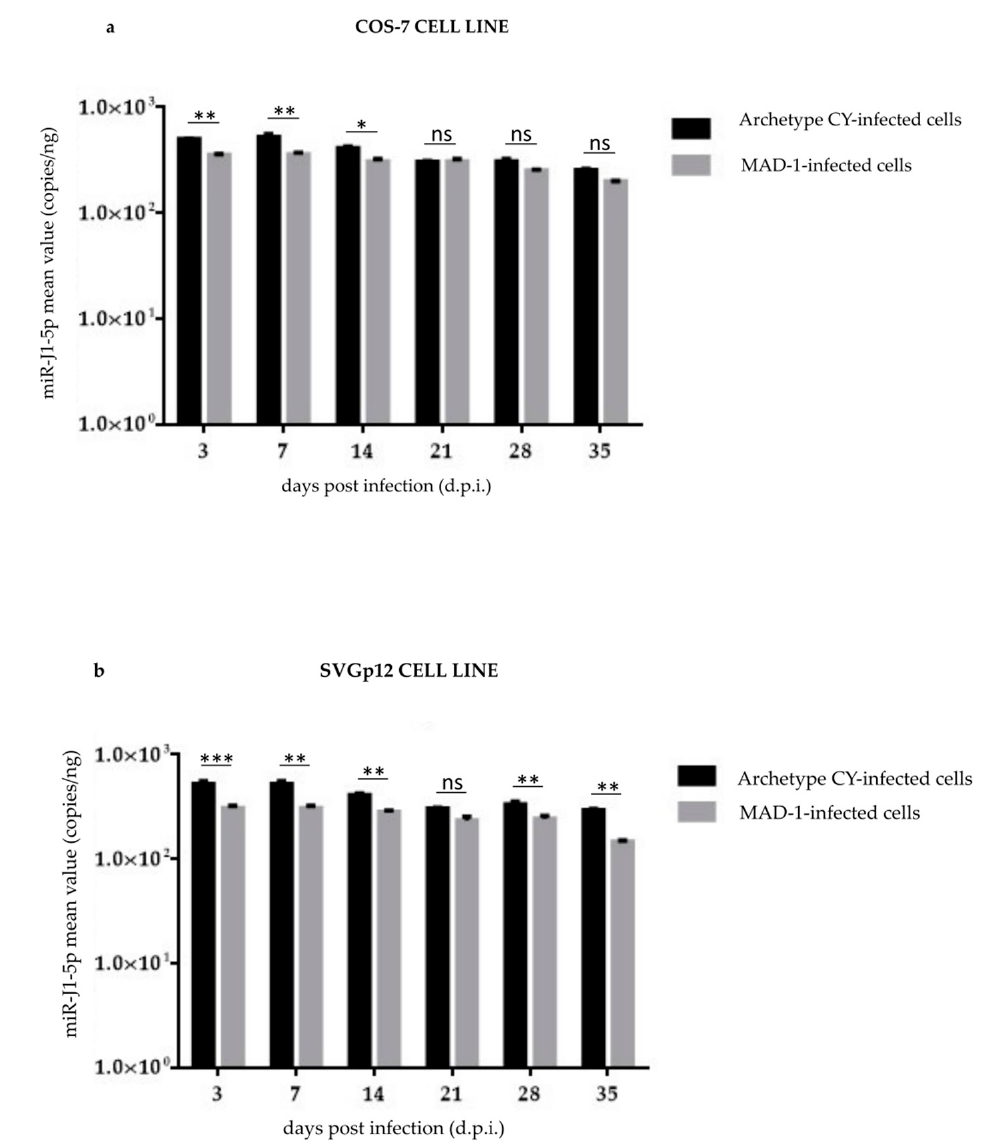
Figure 3. Expression of miRNA levels observed in exosomes generated during archetypal and MAD-1 JCPyV infection of COS-7 and SVGp12 cell lines: ( a ) JCPyV miR-J1-5p expression was quantified by quantitative TaqMan real-time PCR at selected sampling times after infection, from 3 d.p.i until 35 d.p.i.; data are expressed as the mean of three independent experiments, and error bars indicate standard deviations; ns: not significant; * p < 0.05; ** p < 0.01. The results showed that JCPyV miRNA was present in the exosomes starting from 3 d.p.i. during archetypal and MAD-1 JCPyV infection of the COS-7 cell line. A higher expression of miRNA levels was observed in exosomes generated during archetypal JCPyV infection than was observed for the rr ‐ NCCR. ( b ) JCPyV miR ‐ J1 ‐ 5p expression was quantified by quantitative TaqMan real ‐ time PCR at selected sampling times after infection, from 3 d.p.i until 35 d.p.i;. data are expressed as the mean of three independent ex ‐ periments, and error bars indicate standard deviations; ns: not significant; ** p < 0.01; *** p < 0.001. The results showed that JCPyV miRNA was present in the exosomes starting from 3 d.p.i. during archetypal and MAD ‐ 1 JCPyV infection of the SVGp12 cell line. A higher expression of miRNA